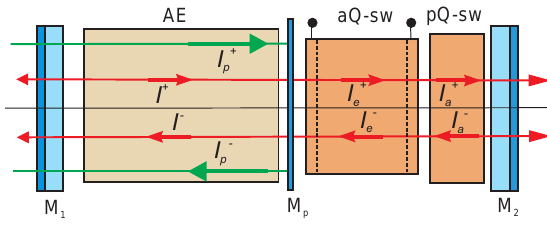
Figure 1. Scheme of an actively and (or) passively Q-switched